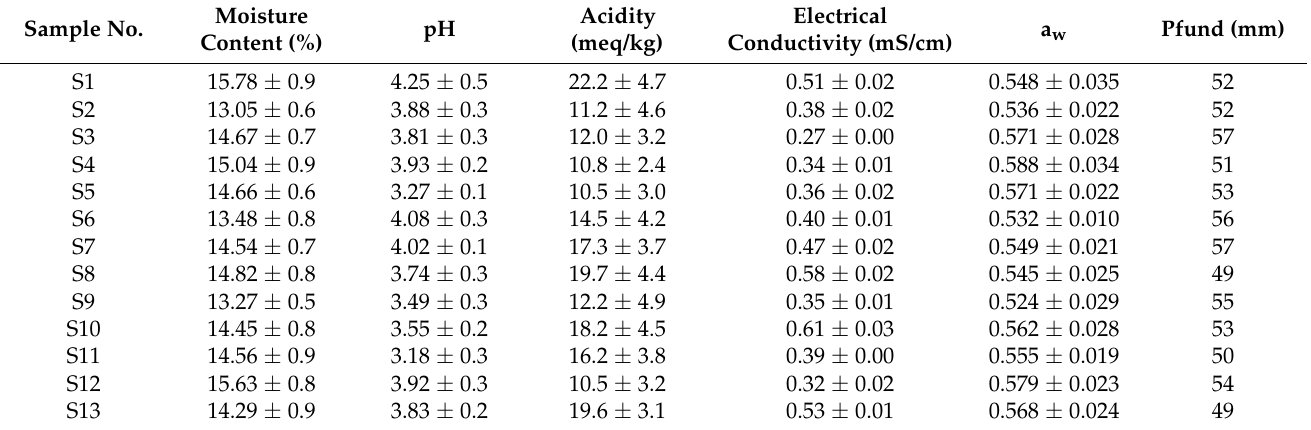
Table 1. Physicochemical parameters of honey samples from North-West and Central Romania. Sample